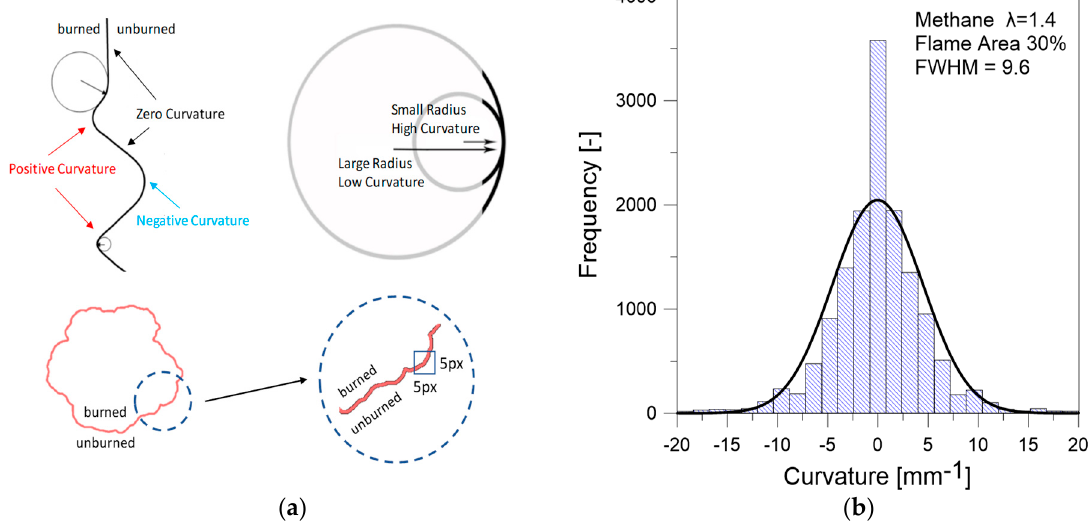
Figure 4. ( a ) Schematic representation of the procedure used for measuring flame curvature, and ( b ) histogram representative of the curvature frequency distribution and related Gaussian fitting curve evaluated for methane in baseline conditions.